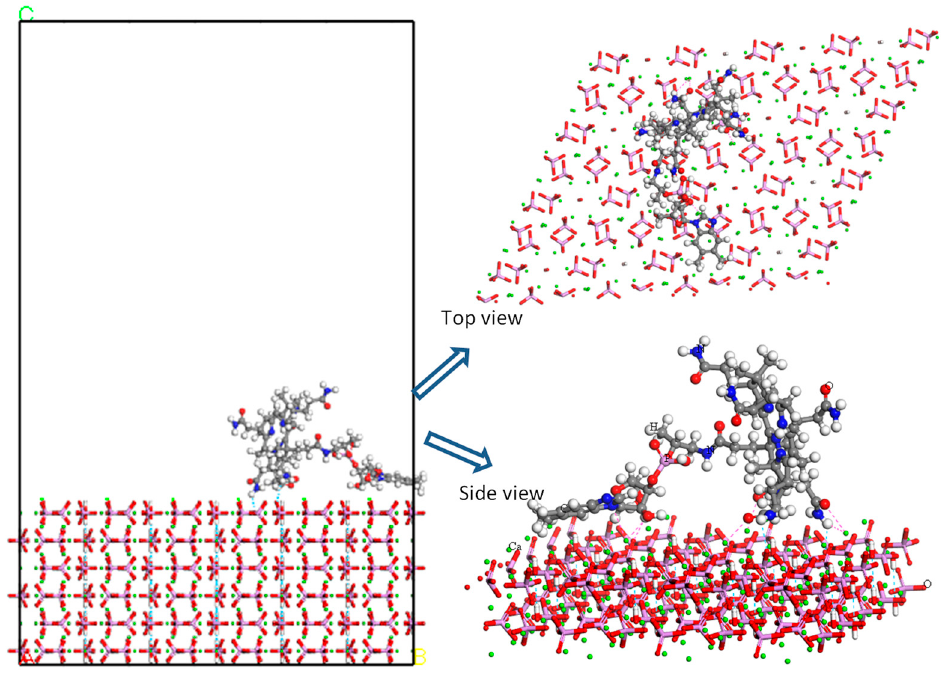
Figure 3. Adsorption of Vit B 12 on the (0 1 0) HAP surface as obtained from the Monte Carlo simulation.